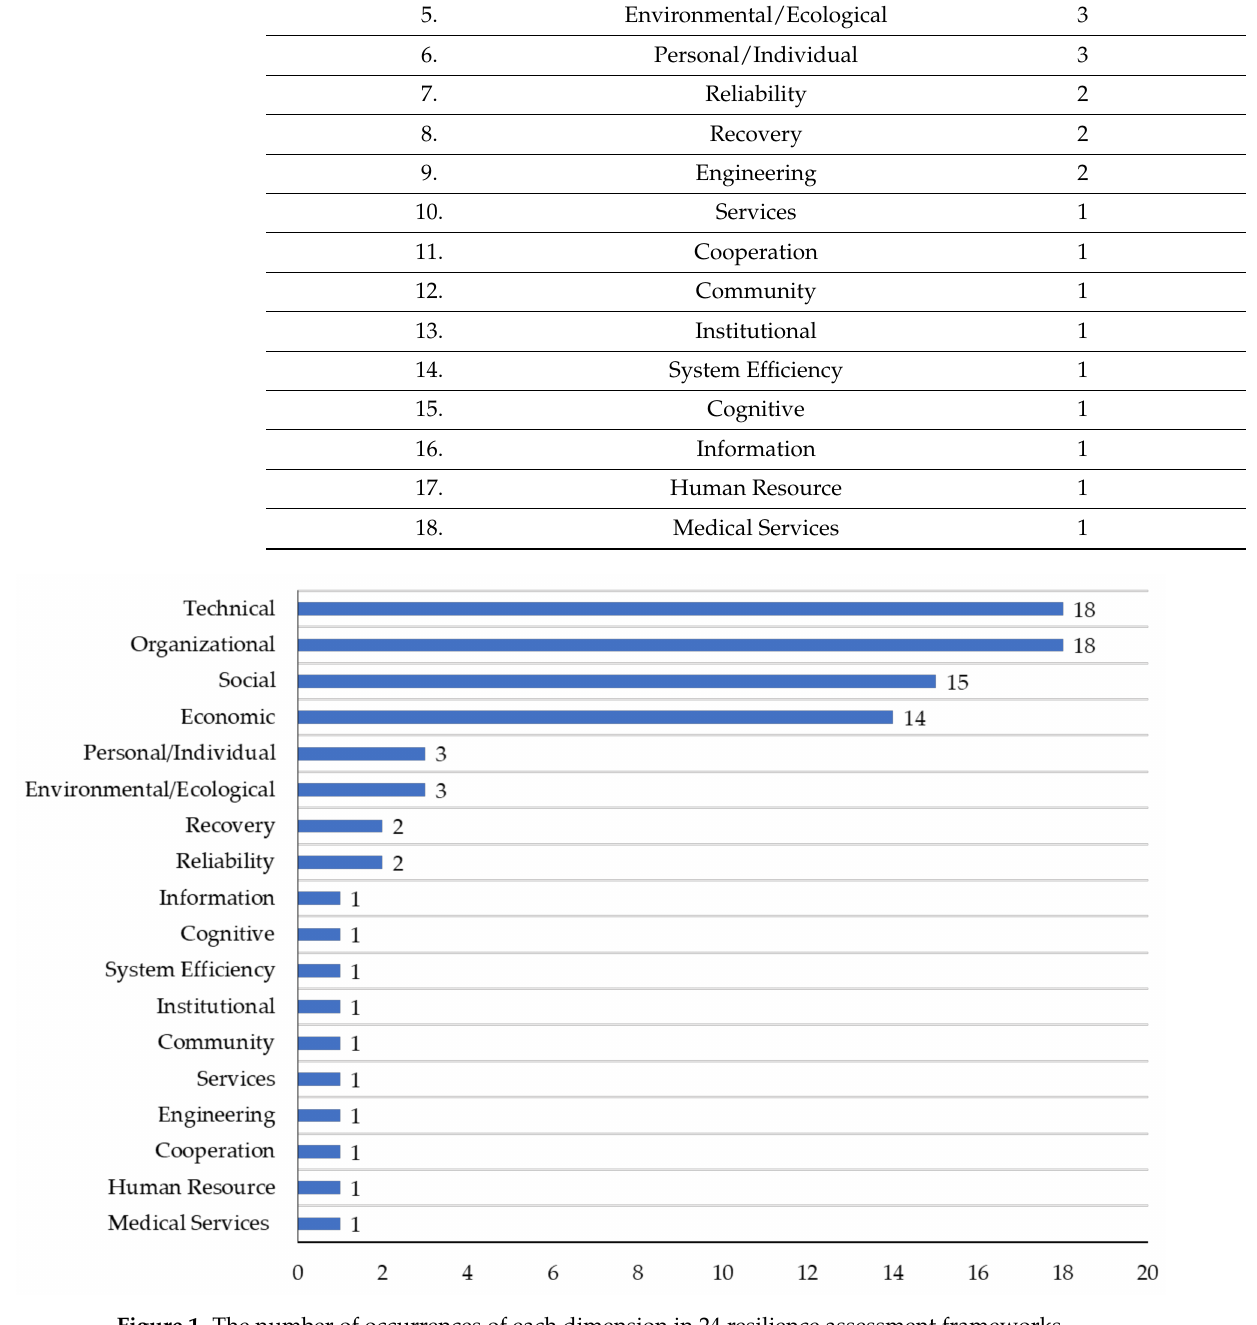
Figure 1. The number of occurrences of each dimension in 24 resilience assessment frameworks. The social dimension of resilience looks at the capacity of social relationships and networks to lessen the negative effects of catastrophes, explaining society’s response to disruptive events [89,90]. Social resilience is described by Adger [91] as the ability of